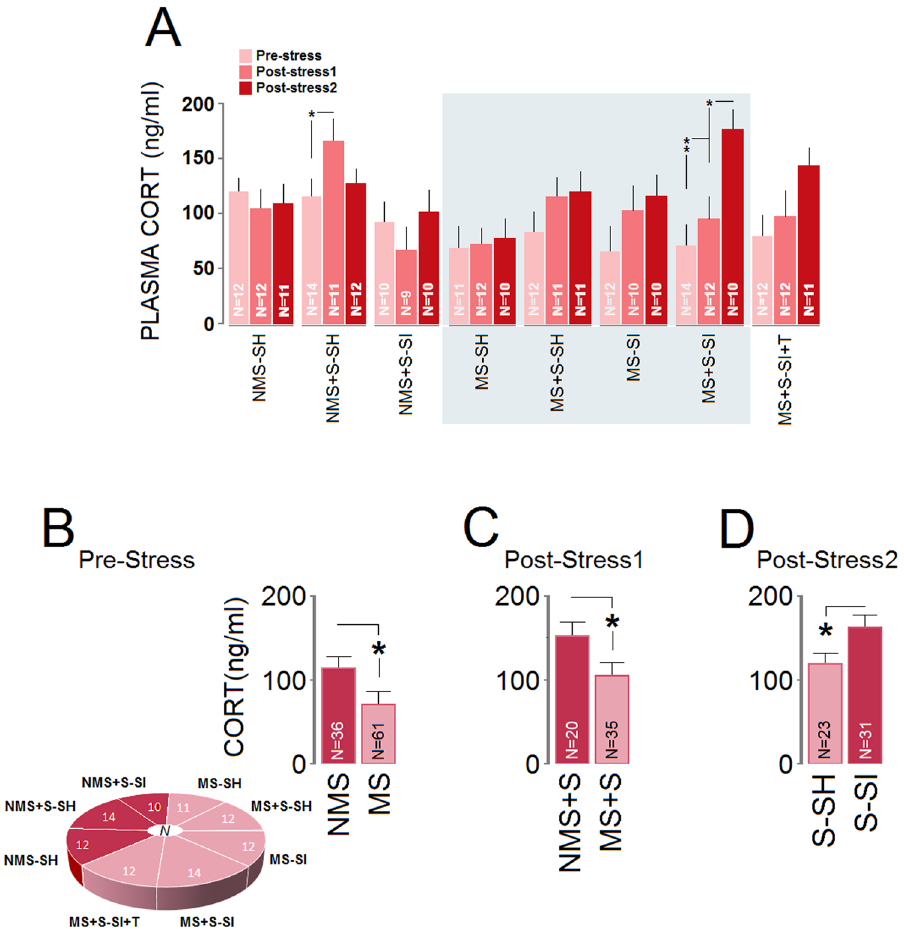
Figure 2. Stress and social isolation exacerbate stress response in ancestrally stressed rats . Shown are plasma corticosterone levels two days before stress (Pre-stress), the first day of stress (Post-stress1), and the last day of stress (Post-stress2). ( A ) Plasma CORT significantly rose in MS + S-SI rats in response to stress exposure only in the chronic phase. ( B – D ) Comparison of changes in CORT levels influenced by maternal multigenerational stress and the double-hit protocol at different time points. Asterisks indicate significant differences: * p ≤ 0.05, ** p ≤ 0.01; ANOVA. Error bars show ±